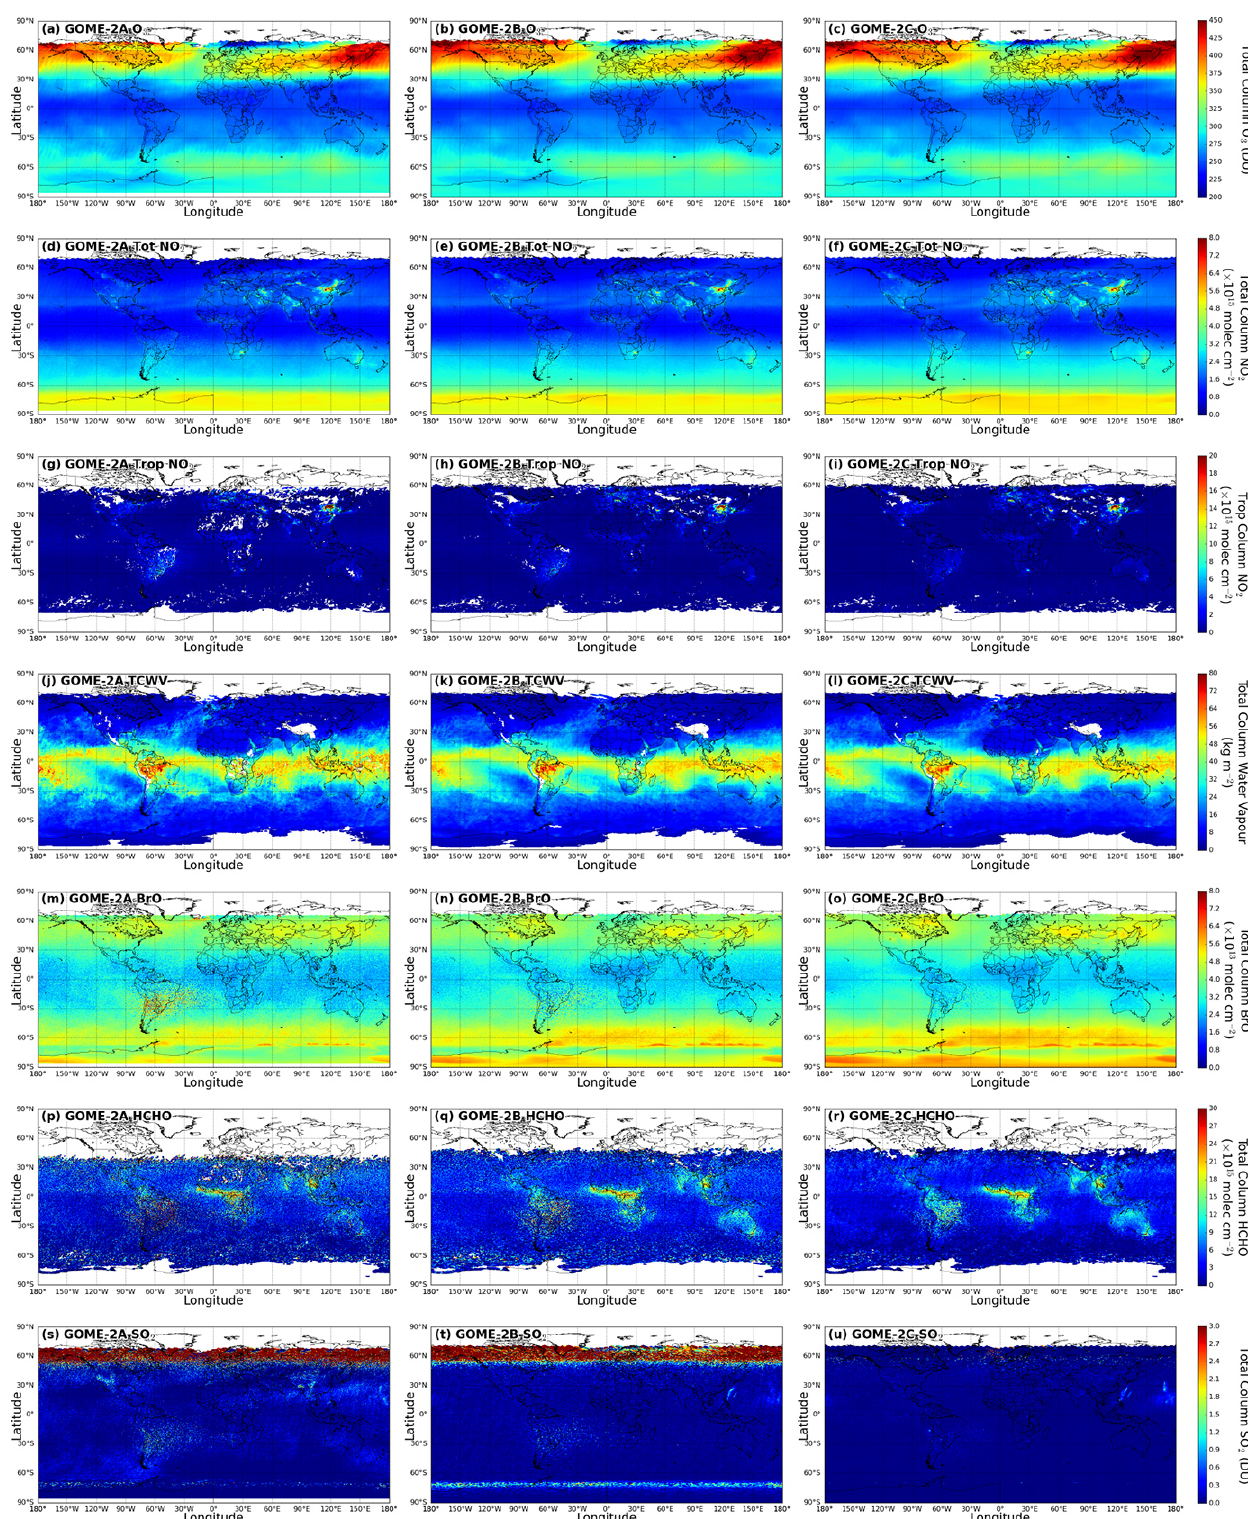
Figure 5. Monthly level-3 product of GOME-2A (first column), GOME-2B (second column), and GOME-2C (third column) for Jan- uary 2020. Total column O 3 (first row), total column NO 2 (second row), tropospheric column NO 2 (third row), total column water vapour (fourth row), total column BrO (fifth row), total column HCHO (sixth row), and total column SO 2 (seventh row) are shown.